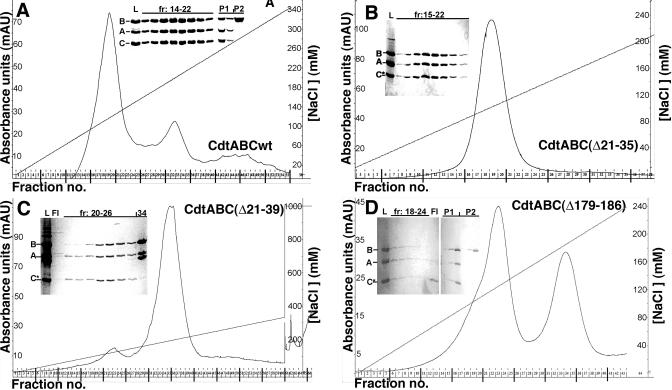
Cation-Exchange Chromatography of CDT Holotoxin Containing N- and C-Terminal Deletions of CdtCWild-type (A) or mutant CDT holotoxins [(B) holotoxin with CdtC (Δ21−35), (C) holotoxin with CdtC (Δ21−39), (D) holotoxin with CdtC (Δ179−186)] were run on Fast Flow SP Sepharose columns (20 ml) using an ÄKTA FPLC. Refolded CDT complexes were loaded on an SP Sepharose column in buffer containing 40 mM NaCl, 20 mM HEPES (pH 7.5), 2.5 mM DTT and analyzed by a gradient in salt concentration as described in Materials and Methods. Individual fractions (5 ml) or pooled material (P) from elution peak were collected and examined by SDS-PAGE. Proteins were stained with Coomassie blue dye. Images of the gels are presented inside corresponding chromatograms. The peak that elutes between 100 and 150 mM NaCl concentration (P1) contains an intact CDT holotoxin, and the second peak (P2) that elutes at concentrations higher than 200 mM NaCl contains only the CdtB subunit. A, CdtA; B, CdtB; C, CdtC; C*, deletion mutants of CdtC; L, loaded material; fr, fraction number; Fl, flowthrough; P, pooled material from elution peak. Absorbance was measured at 280 nm. In A, P1 contains fractions 14−22, and P2 contains fractions 31−34; in D, P1 contains fractions 20−22, and P2 contains fractions 32−34.